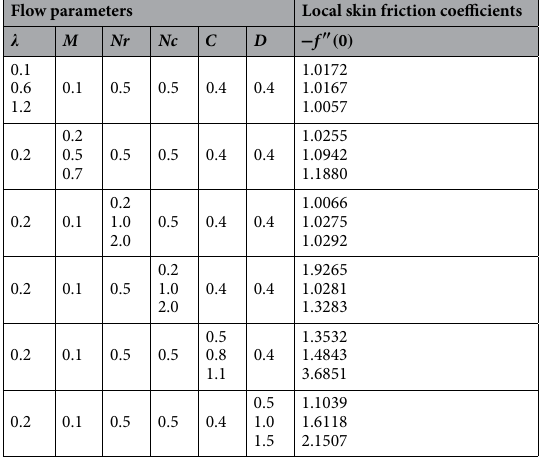
f ′′ ( 0 ) versus flow parameter. −